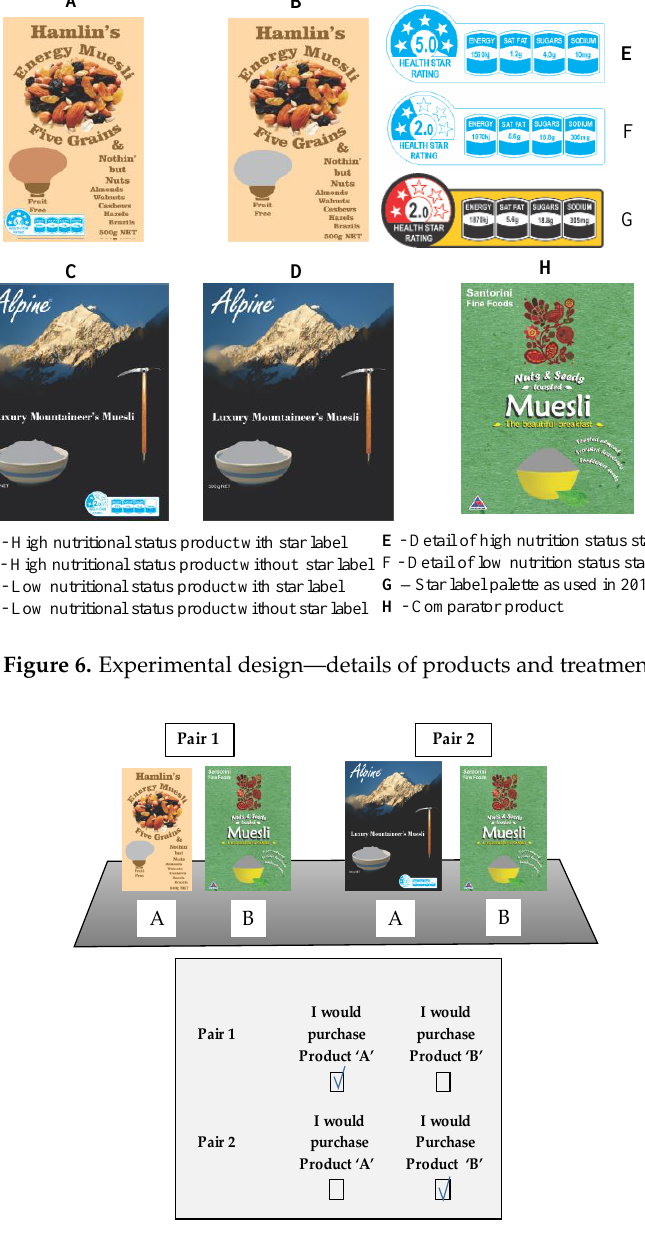
Figure 7. Experimental design, presentation of FoP labels/products and instrument.